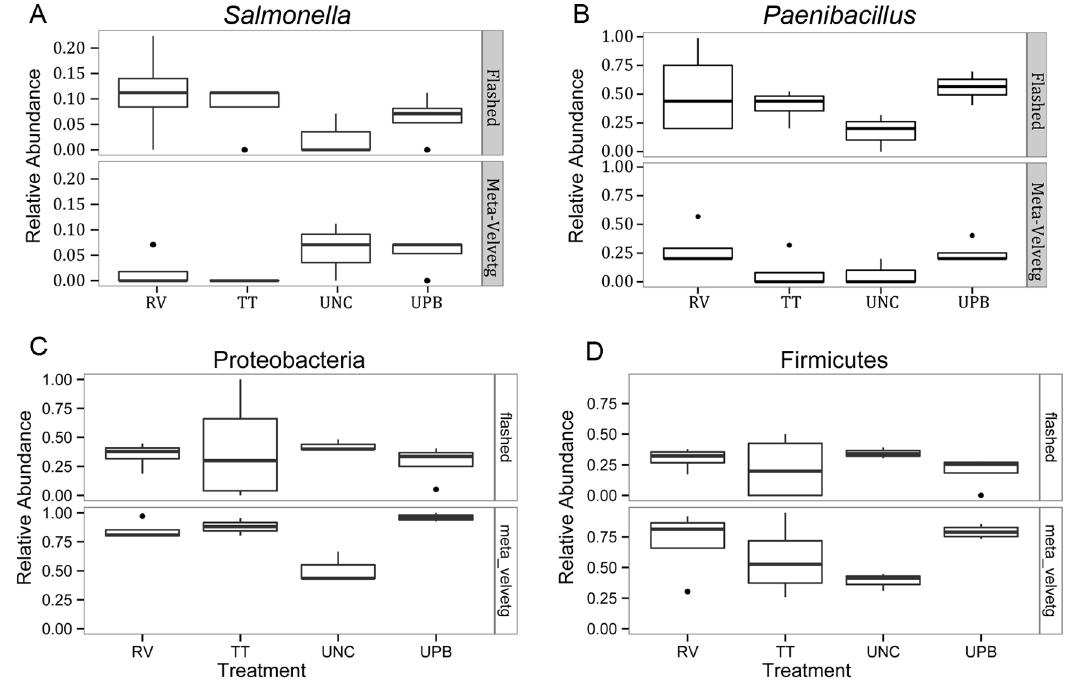
Figure 6. Boxplots of the relative abundance of a) Salmonella , b) Paenibacillus c) Proteobacteria, and d) Firmicutes among the different treatments using the FLASHed and Meta Velvetg assemblies. Boxes show the interquartile range, bars illustrate the median, and the whiskers extend out to 1.5 times the interquartile range.